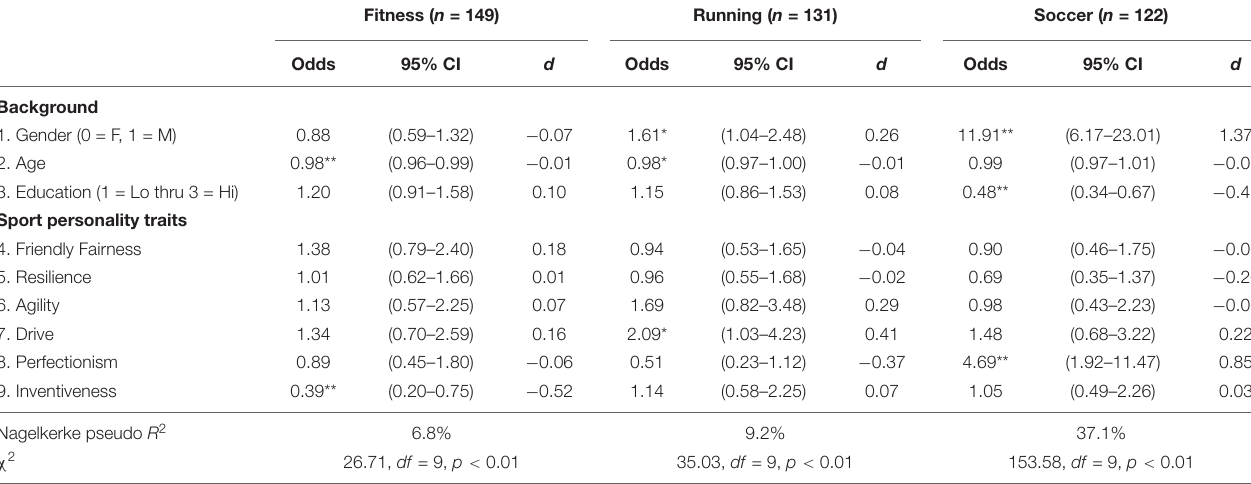
TABLE 4 | Logistic regression of the most practiced sports and leisure activities on background and sport personality traits ( N = 555).